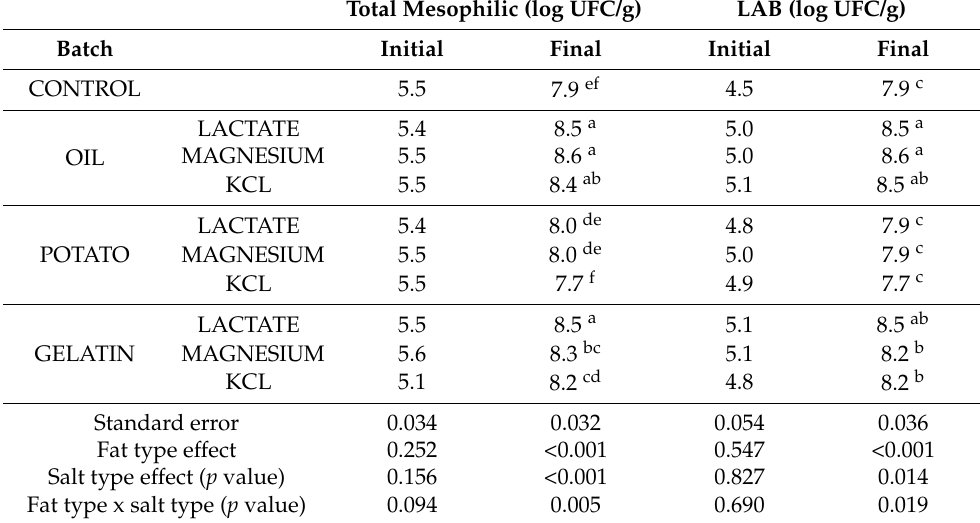
Table 4. The means and standard error for microbial counts of 10 experimental batches of dry- fermented sausages and the p values for studied effects (fat type and salt